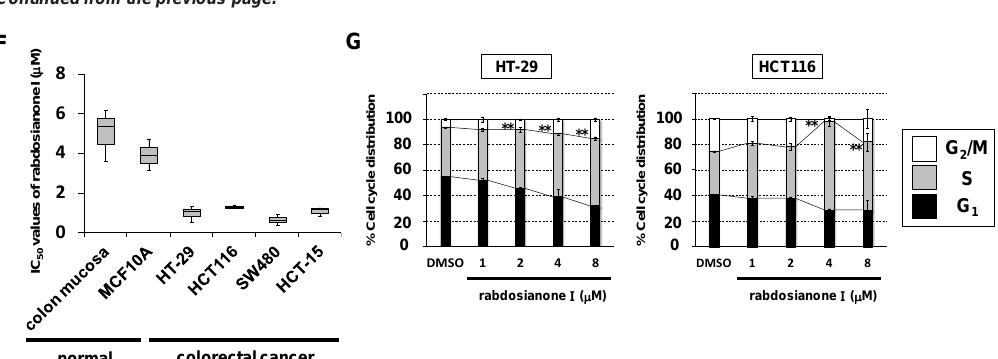
Figure 1. Rabdosianone I inhibits cell growth by inducing S phase arrest. ( A ) Distant view (left panel) and close-range view (right panel) of Isodon japonicus Hara. ( B ) Chemical structure of rabdosianone I. ( C ) The dose-dependency of the growth inhibitory effect of rabdosianone I. HT-29 and HCT116 cells were treated with rabdosianone I at the indicated concentrations for 24 h. Cell viability was measured using a Cell Counting Kit-8 assay at the indicated times. Results with DMSO (dimethyl sulfoxide) were taken as 100%. Columns, means ( n = 3); bars, SD. ** p < 0.01, significantly different from the DMSO-treated control. ( D ) The time dependency of the growth inhibitory effect of rabdosianone I. HT-29 cells were treated with rabdosianone I at the indicated concentrations for 24 h. Cell viability was measured using a Cell Counting Kit-8 assay at the indicated times. Each result of OD450 nm value with day 0 (treatment day) were taken as 1. Points, means ( n = 3); bars, SD. * p < 0.05, ** p < 0.01, significantly different from the DMSO-treated control. ( E ) Effects of rabdosianone I on colony formation. HT-29 and HCT116 cells were treated with rabdosianone I at 4 µ M. After further incubation, colonies were fixed and stained by crystal violet. The images of stained colonies are shown (upper panel). Colony formation rate is shown in the graph (lower panel). Columns, means ( n = 3); bars, SD, ** p < 0.01, significantly different from the DMSO-treated control. ( F ) The difference of IC 50 values of rabdosianone I between non-cancerous and cancer cell lines. The growth inhibition curve of cells treated with rabdosianone I for 72 h was determined using a Cell Counting Kit-8 assay. The IC 50 values of rabdosianone I in non-cancerous cell lines (mouse colon mucosa cells and MCF-10A cells) and human colorectal cancer cell lines (HT-29, HCT116, SW480, and HCT-15) were obtained from each growth inhibition curve. The grouped data of IC 50 values from three independent experiments are shown as box plots. The median value is shown by a horizontal line in the box plot. ( G ) Cell cycle analysis following rabdosianone I treatment. HT-29 and HCT116 cells were treated with rabdosianone I at the indicated concentrations for 72 h. The DNA content of the cells was determined by flow cytometry. The percentages of cells in the G 1 , S, and G 2 /M phases of the cell cycle are shown. Columns, means ( n = 3); bars, SD. ** p < 0.01, significantly different from the S phase distribution of the DMSO-treated control.